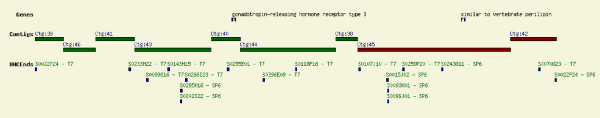
Summary of the Sanger-sequenced BAC (S0022P24). The two genes within the ~200,000 bp region are indicated as well as the nine sequence contigs and two scaffolds (indicated by red and green contigs). The relative orientation of these scaffolds was determined knowing the SP6 and T7 BAC-end sequences. The BAC-end sequences within the region are indicated in the order predicted by the Atlantic salmon physical map. Note that this BAC overlaps with the remainder of the MTP (i.e., that sequenced by GS FLX) at the 70O23-T7 BAC-end.